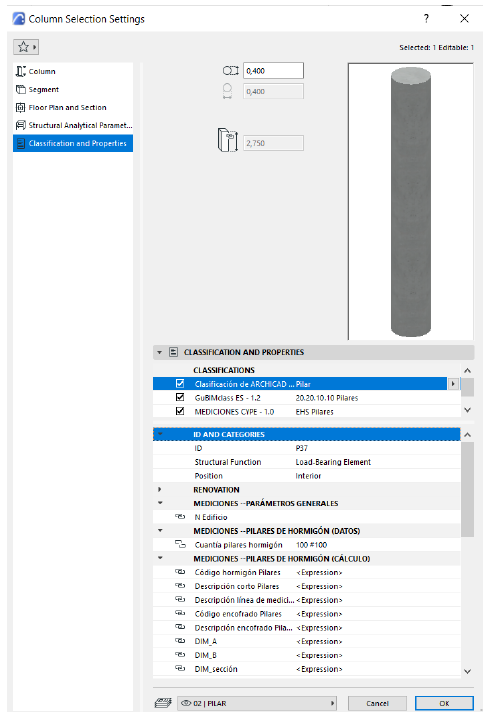
Figure 2. Cype DB (prices in Spain) of formwork items (a) and reinforced concrete pillars (b).